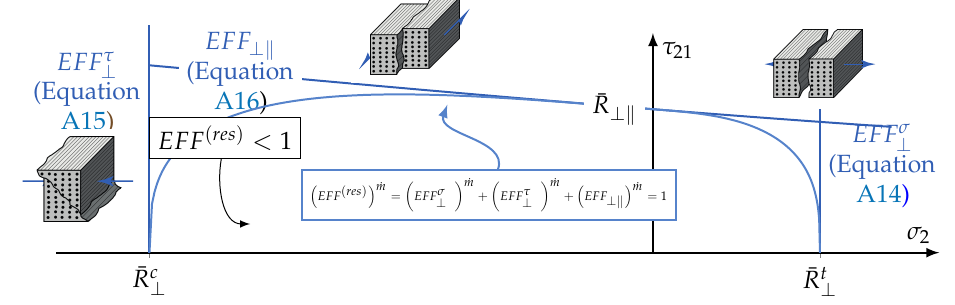
Figure 17. Schematic Illustration of C UNTZE ’s transverse fracture body for the 2D load vector { σ } = ( 0, σ ) (cid:62) and corresponding IFF Modes 2 ,0,0,0, τ 21